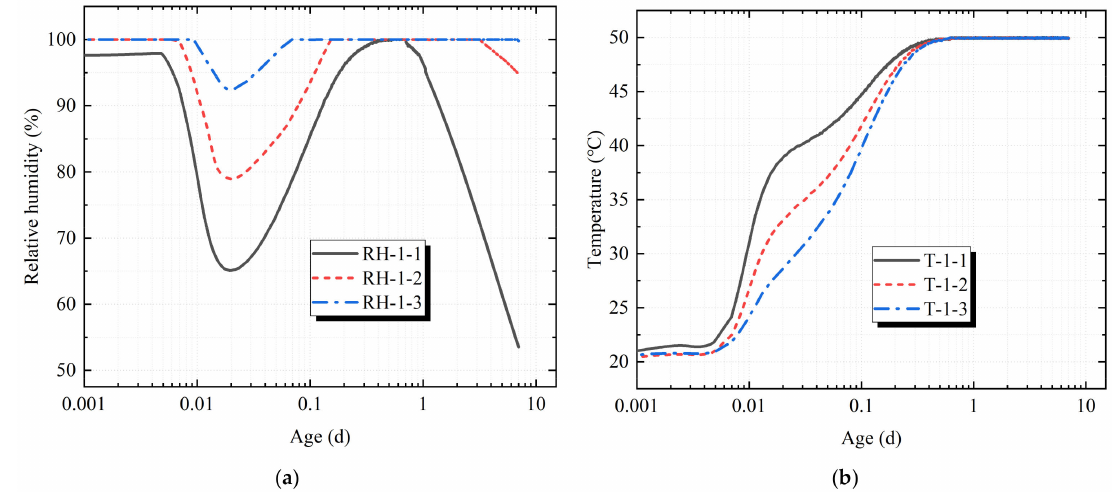
Figure 5. Duration curve of restrained specimen. ( a ) Duration curve of temperature; ( b ) duration curve of relative humidity.